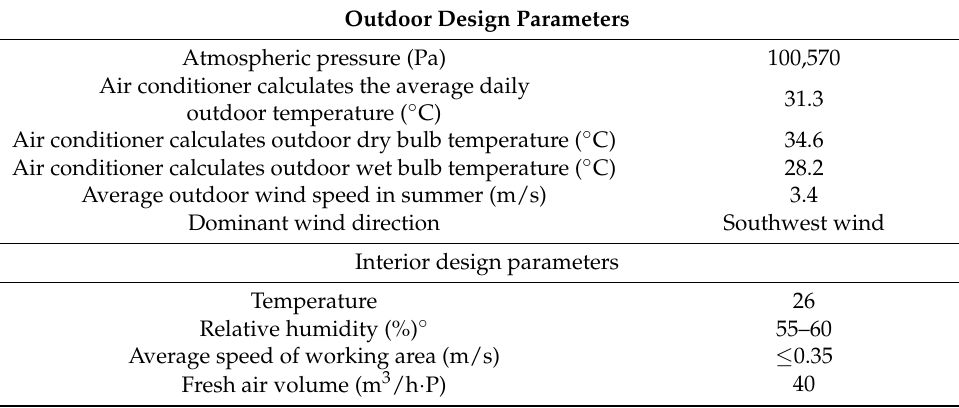
Table 1. Indoor and outdoor design parameters.